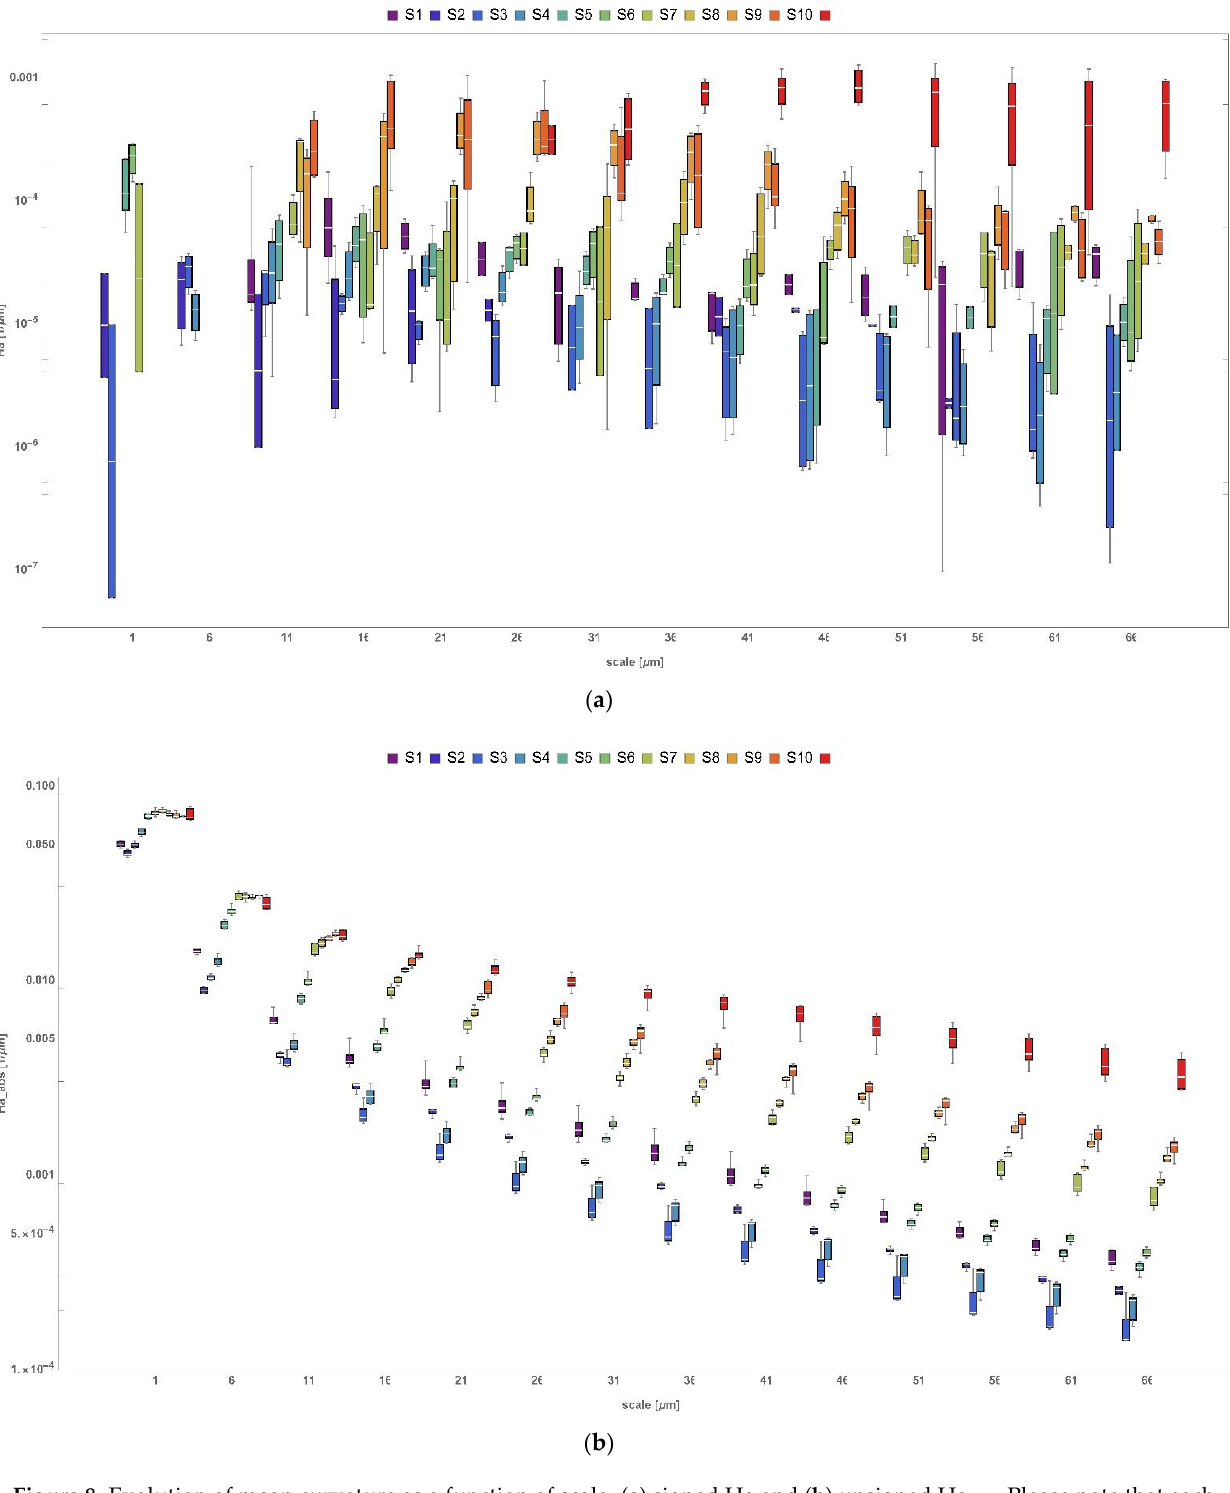
Figure 8. Evolution of mean curvature as a function of scale: ( a ) signed Ha and ( b ) unsigned Ha abs . Please note that each box size indicates 25th and 75th percentiles, the white bar represents median and whiskers shows maximum and minimum values calculated for each scale.